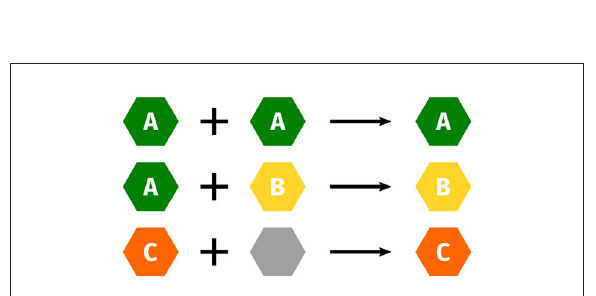
FIGURE3 Ratings of individual components are combined. Neutral ratings (gray) get